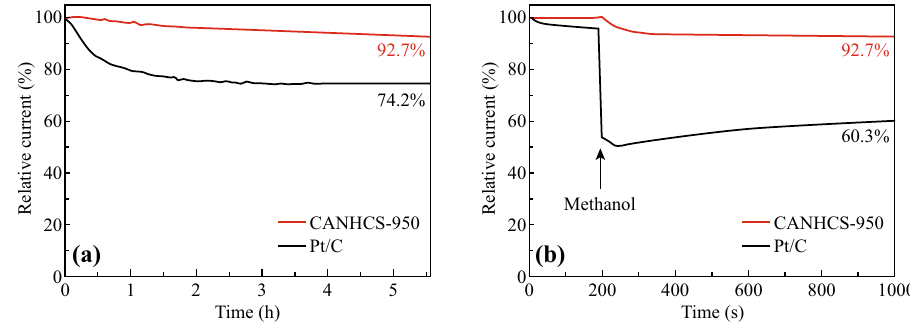
Fig. 10 a Current–time (i-t) chronoamperometric responses for CANHCS-950 and 20% Pt/C in O 2 -saturated 0.1 M KOH electrolyte at - 0.6 V (vs. SCE) for the ORR at a rotating speed of 1600 rpm and b comparison of chronoamperometric responses over 1000 s at a constant rotation speed of 1600 rpm for CANHCS-950 and Pt/C in O 2 -saturated 0.1 M KOH electrolyte with 3 M methanol added at 200